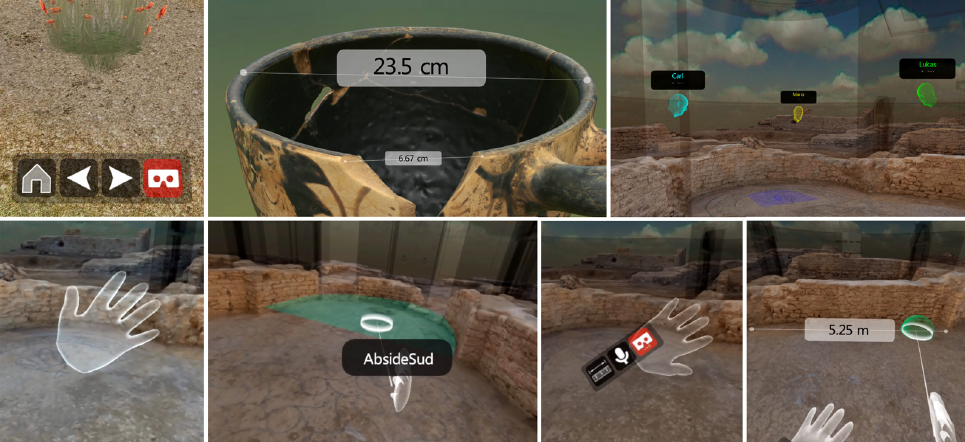
Figure 12. A few applications of spatial UI elements. Top row (from left to right): 3D toolbars in the virtual space with custom events, multiple measurements, 3D floating labels. Bottom row (from left to right): immersive VR hands, semantic labels (VR), wrist interfaces and immersive VR